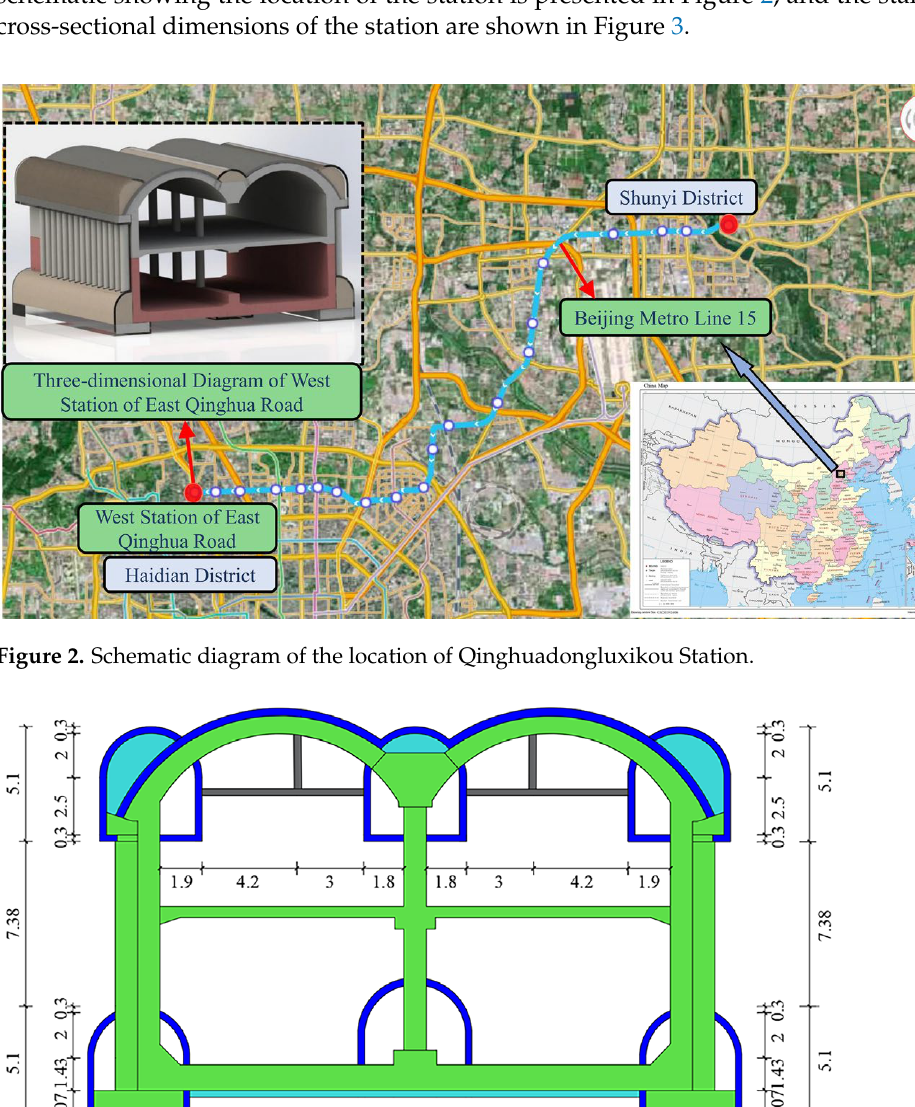
Figure 1. Schematic of the large - span section of Qinghuadongluxikou Station.